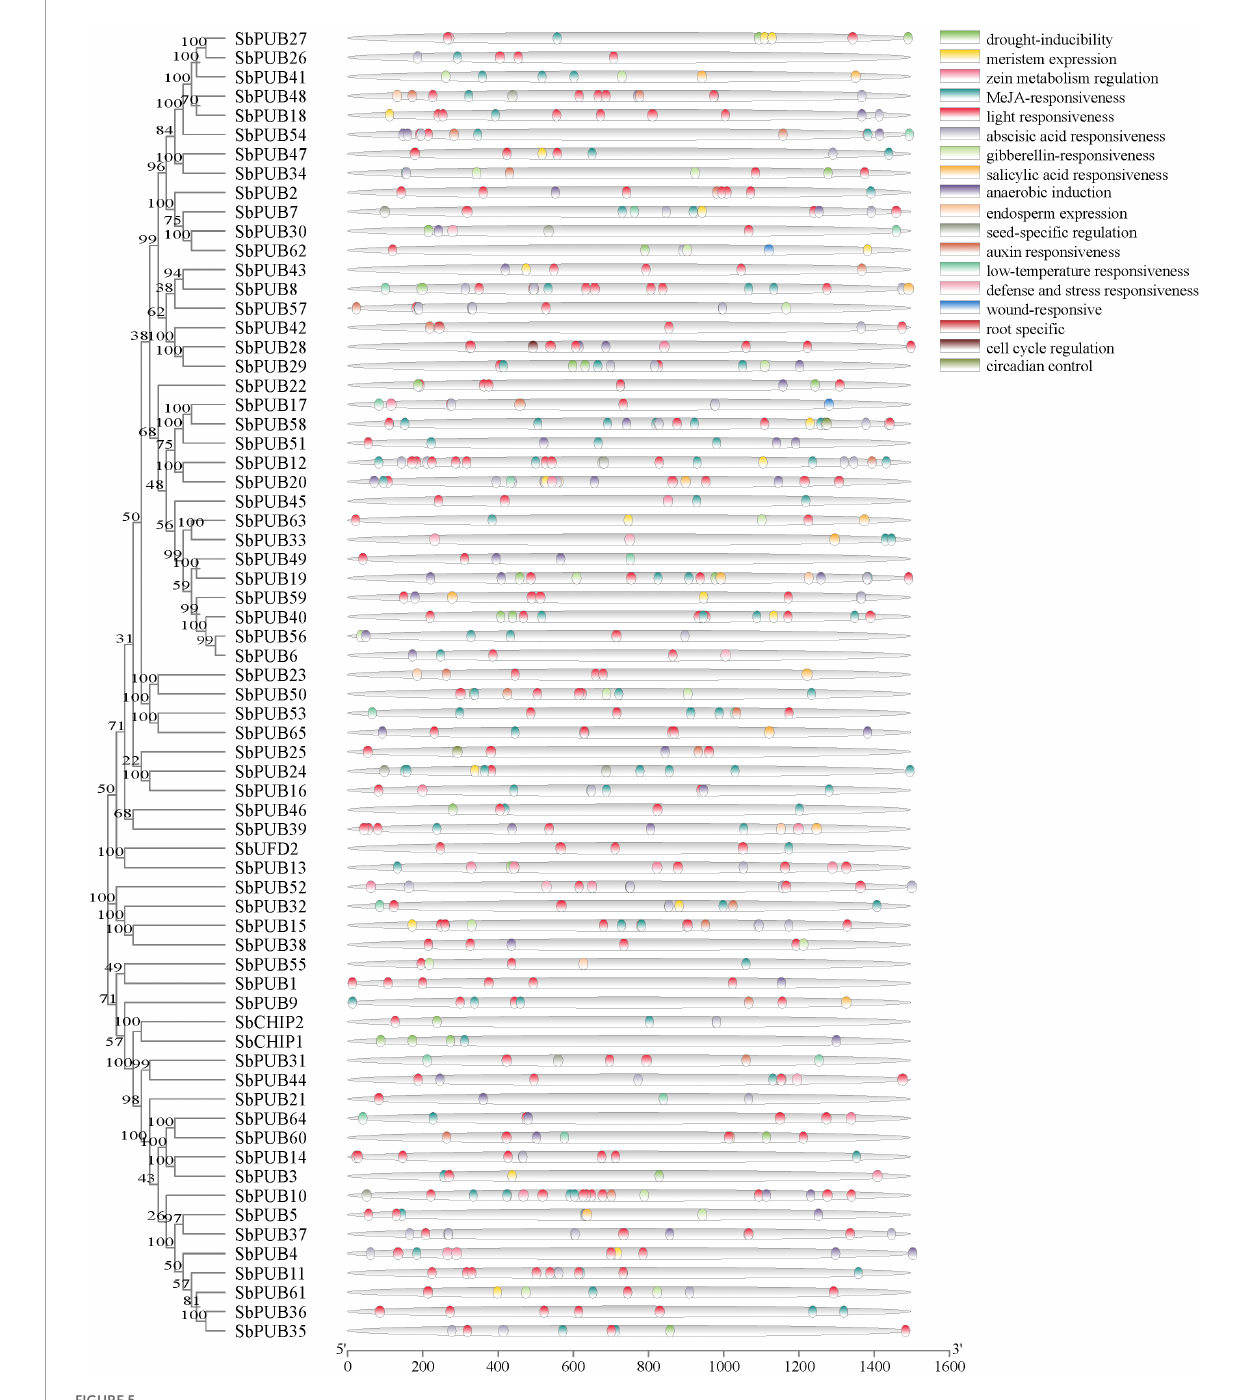
FIGURE5 Promoter analysis of sorghum U-box genes. Rootless trees were generated by the neighbor-joining (NJ) method using MEGA7 software. Numbers next to branches indicate 1,000 bootstrap replicates as a percentage. Different promoters are indicated by rectangles of different colors to represent homeopathic elements. Detailed comments are included in the top right panel.